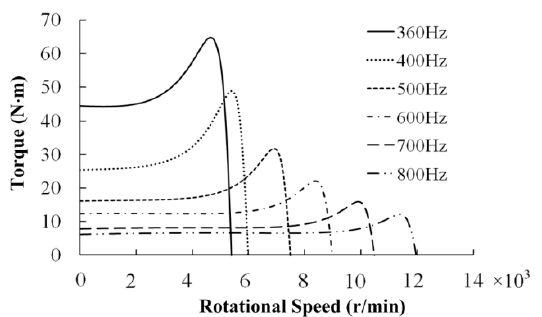
Figure 1. Mechanical characteristics of asynchronous motor with aviation variable frequency power supply.